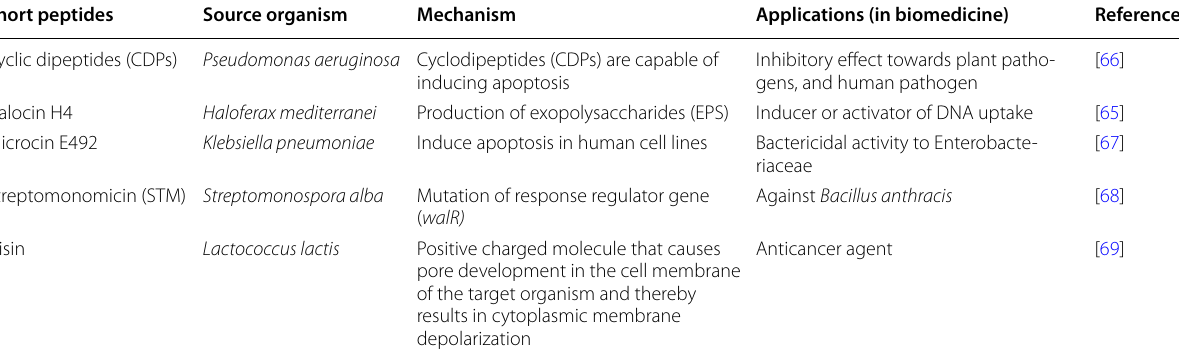
Table 3 Different anti-microbial peptides (AMPs) produced by